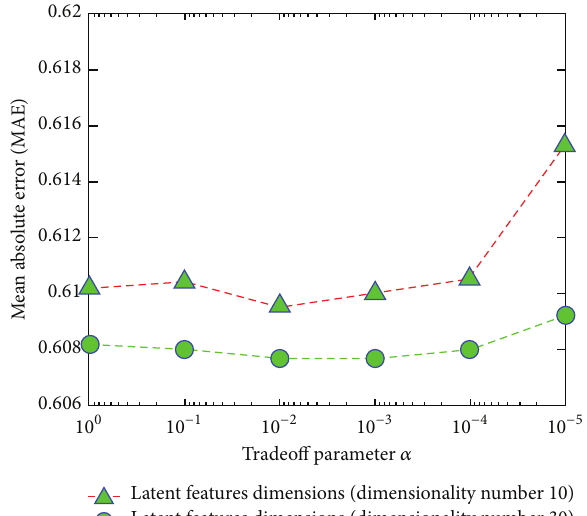
Figure 9: Impact of tradeoff parameter 𝛼 with different dimensions of latent features.